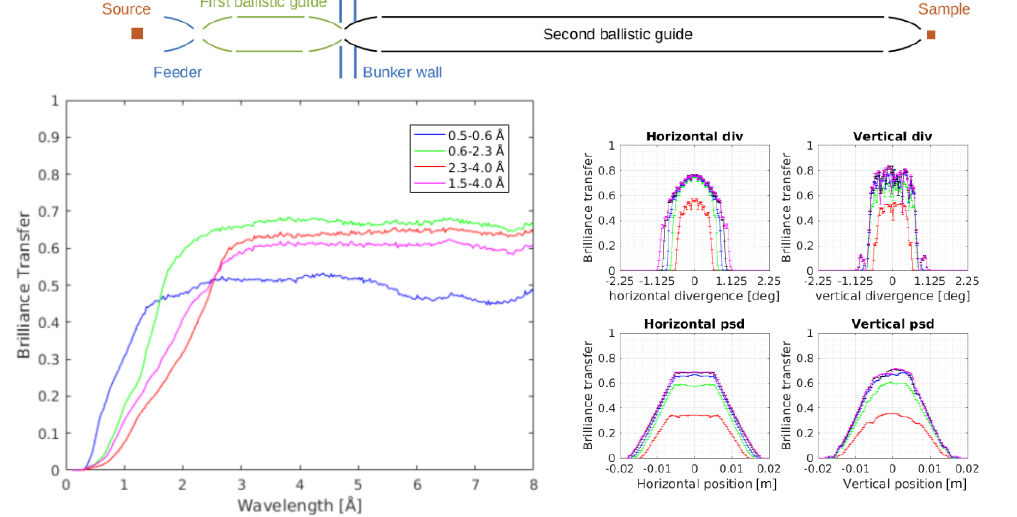
Figure 3. Benchmark 2. Performance of coating-optimized benchmark 2 guides. Top: Schematic drawing of the guide systems that is not to scale. Left: Simulated values of BT ( λ ) as a function of neutron wavelength optimized for coating value and geometry for the wavelength bands WB1 (blue), WB2 (green), WB3b (purple), and WB3a (red), using a pinhole with the size of: height × width = 5 × 3 cm 2 . Right: Integrated BT of the double-pinhole guide, optimized for WB3b, 1.5–4.0 Å. The panels show the BT as a function of horizontal/vertical position and divergence for different wavelengths marked by colors (red: 1.5 Å, green: 2.1 Å, blue: 2.8 Å, black: 3.4 Å, purple: 4.0